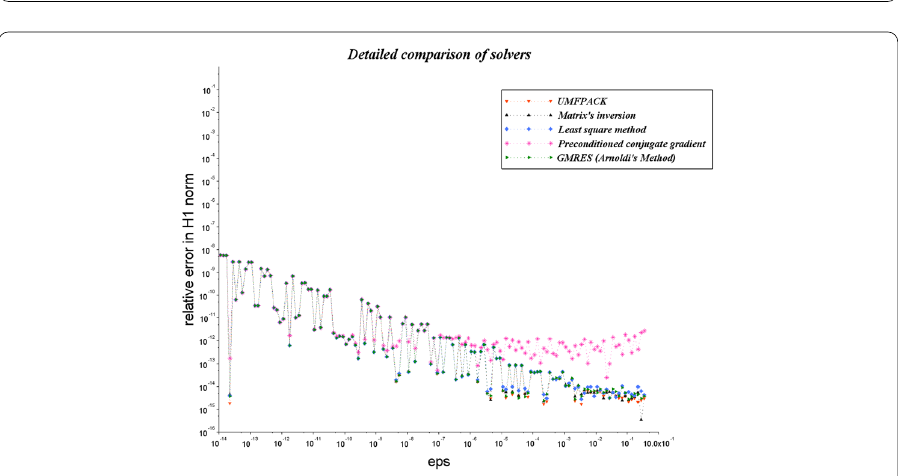
Fig. 13 The use of dedicated pre-conditioner stabilizes the behavior of solvers. But the error still increases with the X-FEM method, as explained in “Numerical analysis of strongly discontinuous approximations with linear elements”